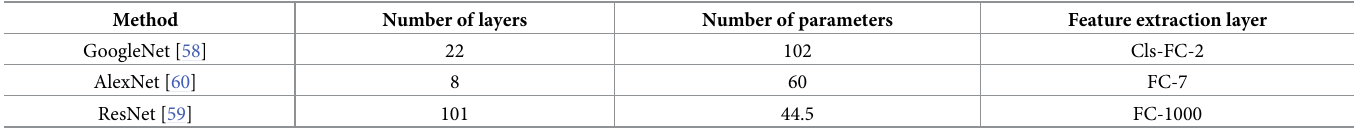
Table 3. Summary of the standard deep learning architectures parameters: Number of layers, and feature extraction layer for each model used in the proposed work on database PHND.